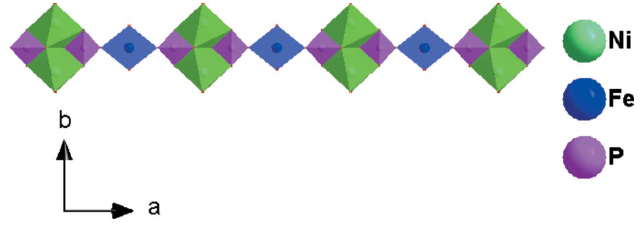
Figure 5 Polyhedral representation of the crystal structure of K 3 Ni 6 Fe(PO 4 ) 6 showing large tunnels running along the [100] direction that contain the K + cations.